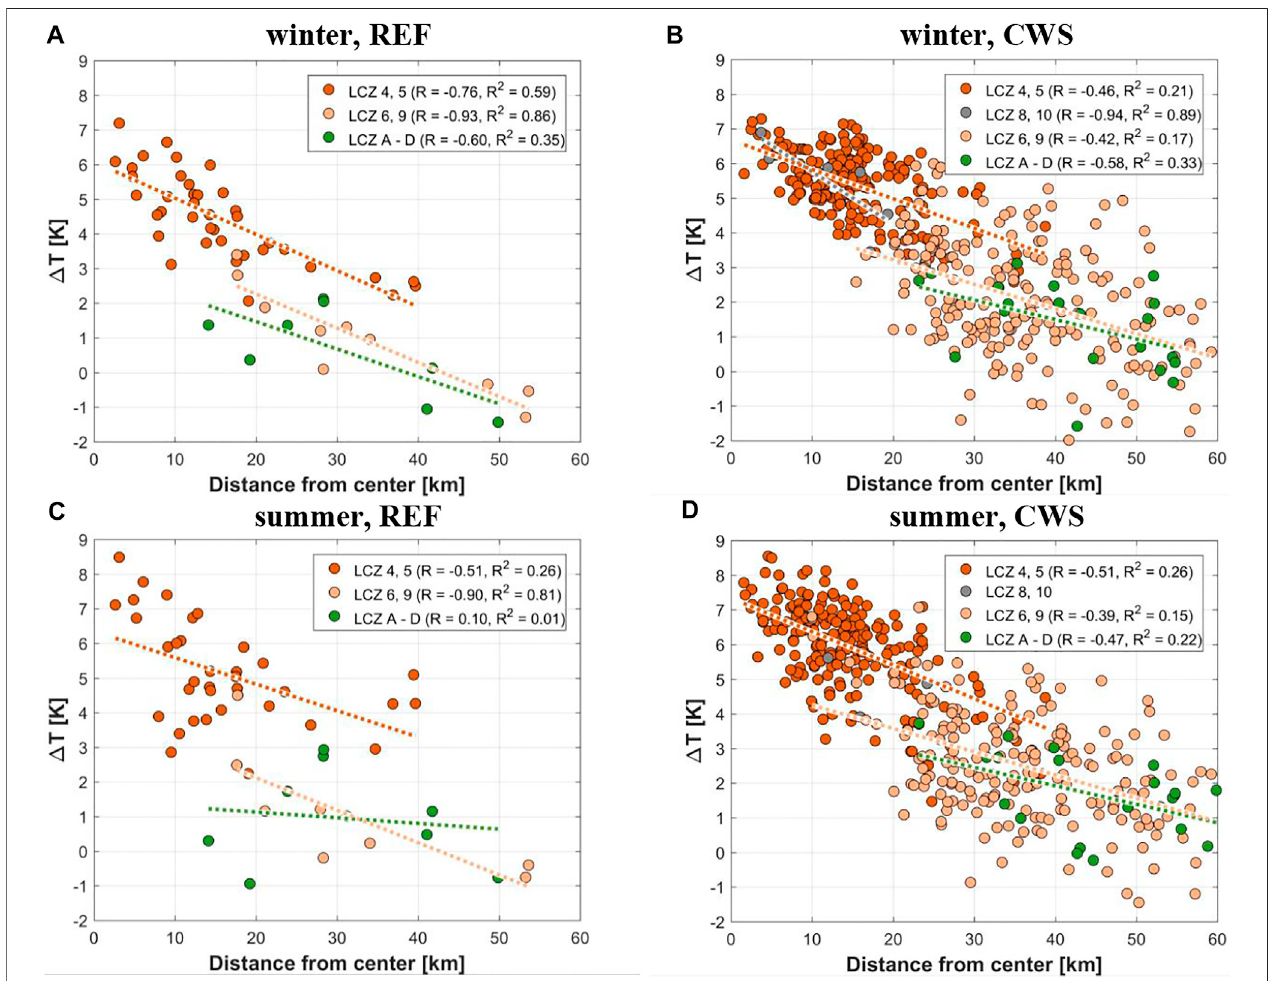
FIGURE7| DependencebetweenUHIintensity Δ T anddistancefromthecitycenterforwinter (A,B) andsummer (C,D) forreferencestations (A,C) andCWSs. R in the legend denotes Spearman correlation coef fi cient, R 2 denotes coef fi cient of determination.